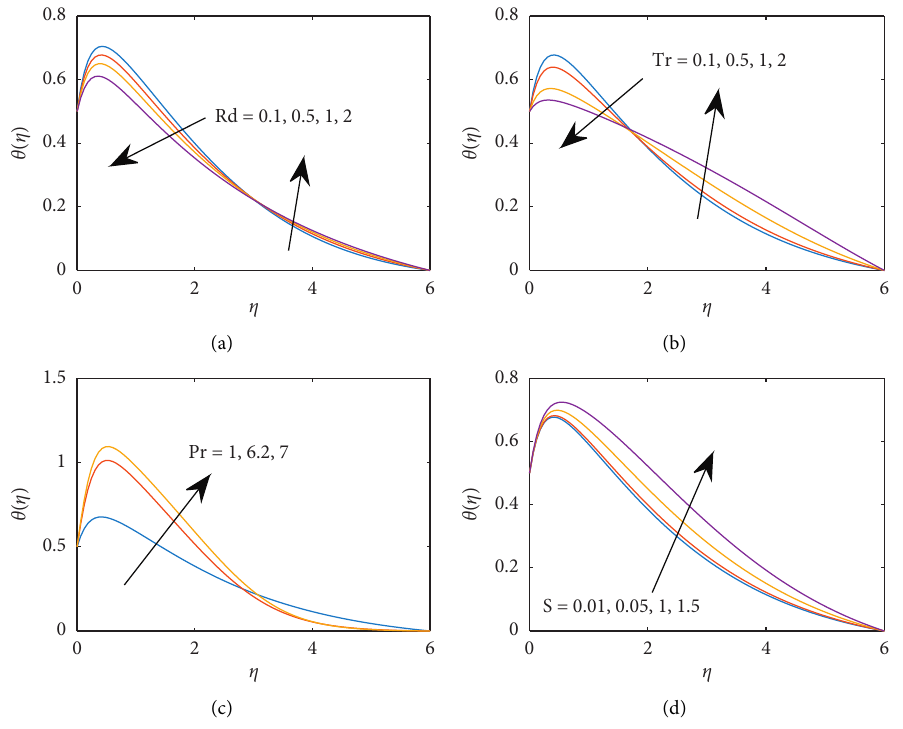
Figure 12: Impact of (a) Rd